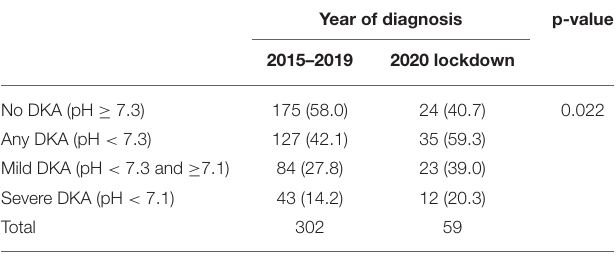
TABLE 2 | Prevalence of DKA (%) at T1D onset in children in Austria during the COVID-19 related lockdown periods in 2020 in comparison to the corresponding previous 5-year periods